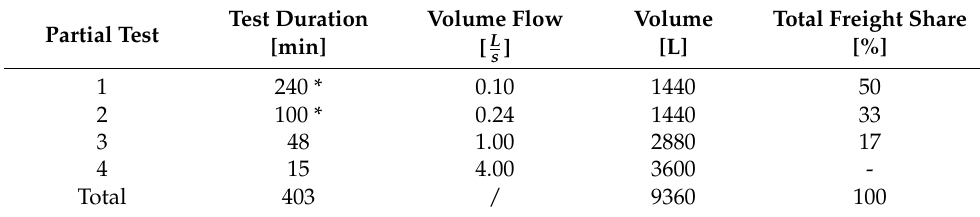
Table 3. Total test for standard shaft [17].